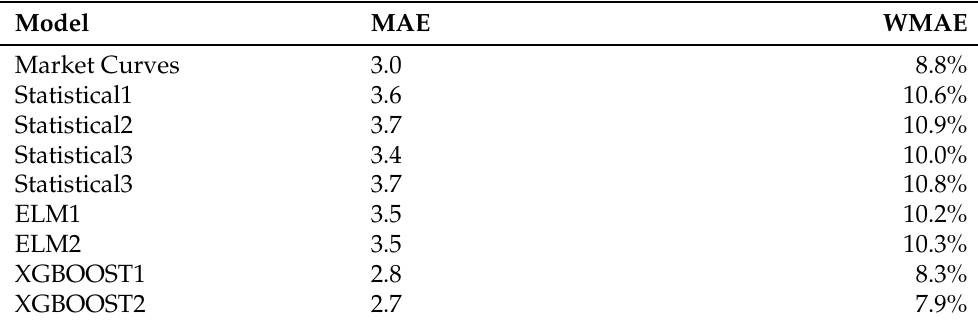
Table 1. Model results and benchmark against industry sector models.